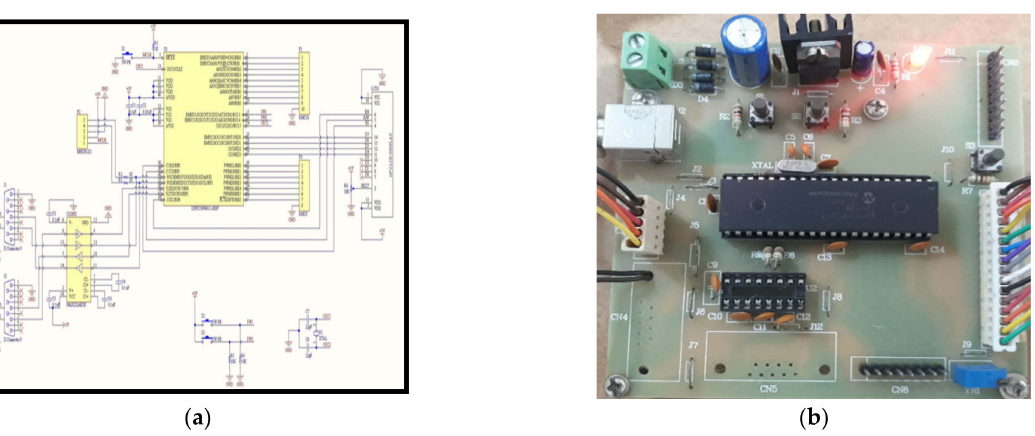
Figure 13. ( a ) Schematic layout of the dsPIC 30f4011 controller; ( b ) real hardware circuit of the dsPIC 30f4011 controller